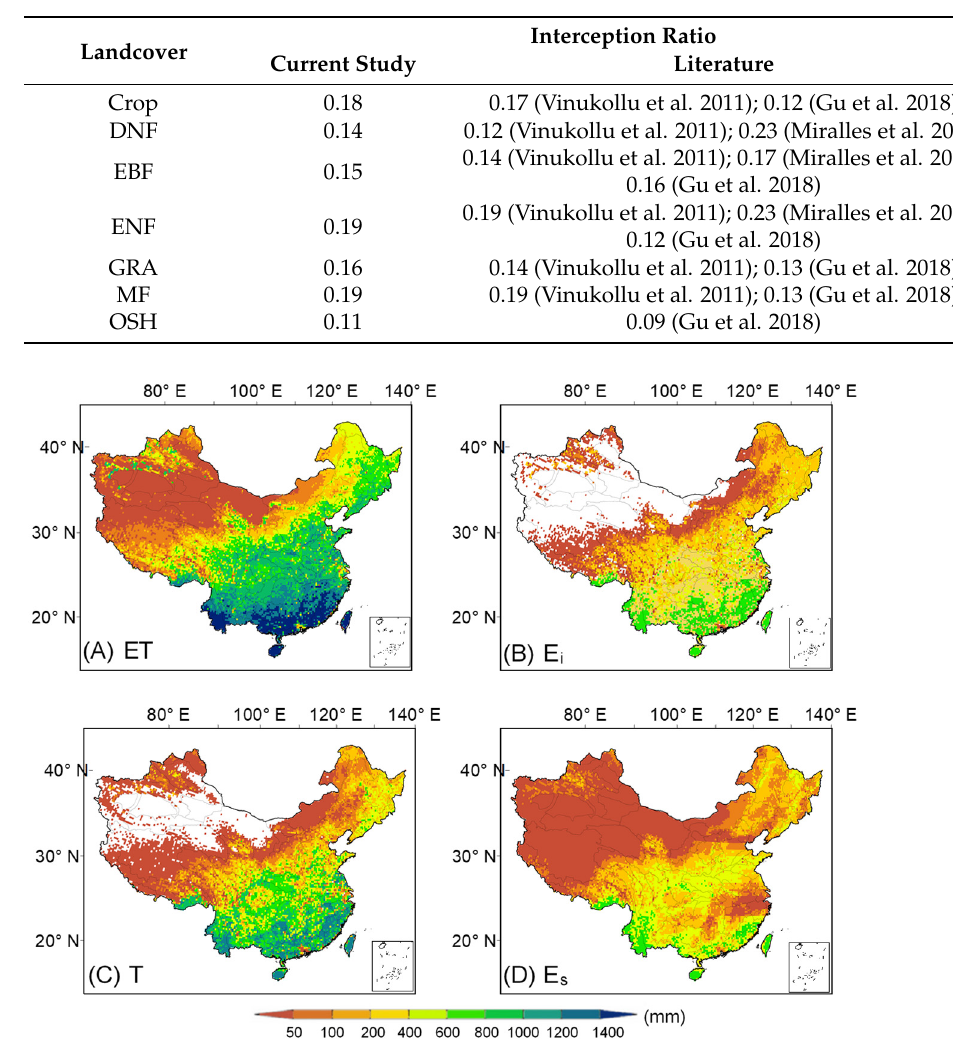
Figure 9. ( A ) Mean annual PT–SM evapotranspiration (ET); ( B ) canopy interception evaporation (Ei); ( C ) vegetation transpiration (T); and ( D ) soil evaporation (Es) of multiyear (2003–2015) in China. The soil evaporation-to-evapotranspiration ratios across different biomes are shown in Figure 8D. The average E s / ET values across biomes range from 0.11 (EBF biome) to 0.49 (OSH biome). The largest variation was noted for the GRA biome, having a greatest range of 0.27–0.39, followed by the Crop biome (range of 0.26–0.35). Our estimated E s / ET values are within the range of previously reported